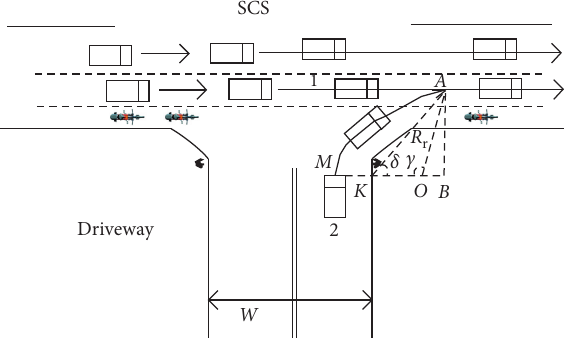
Figure 6: Conflict between right-turning and through